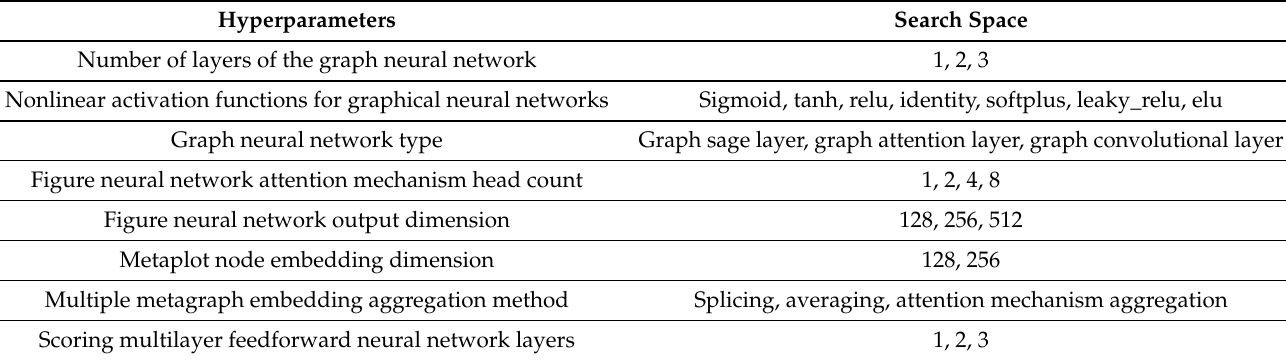
Table 2. Hyperparameters and search space.